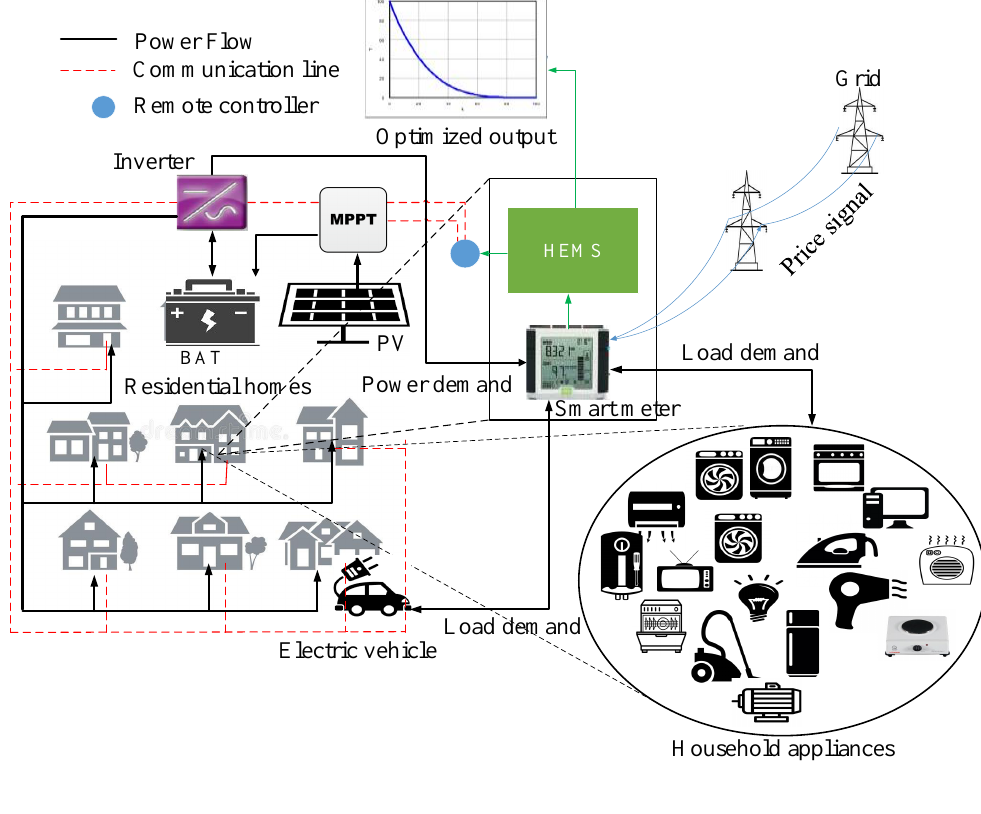
Figure 1. Propose system